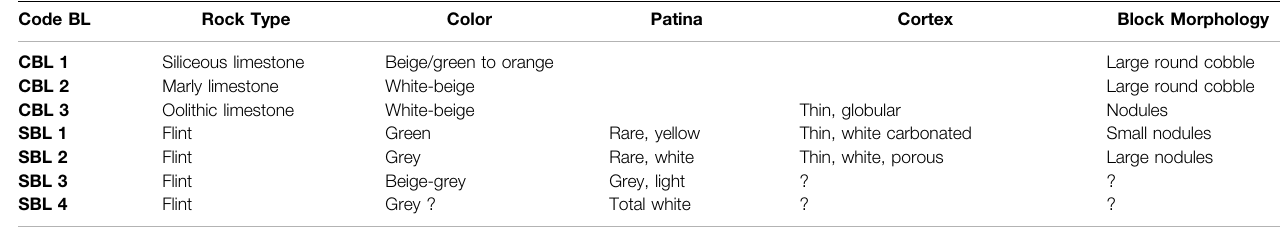
TABLE 2 | Types of rocks identi fi ed macroscopically in the lithic series of Barranco León and Fuente Nueva 3 (after Grégoire, 2009; Toro-Moyano et al., 2010). Barranco